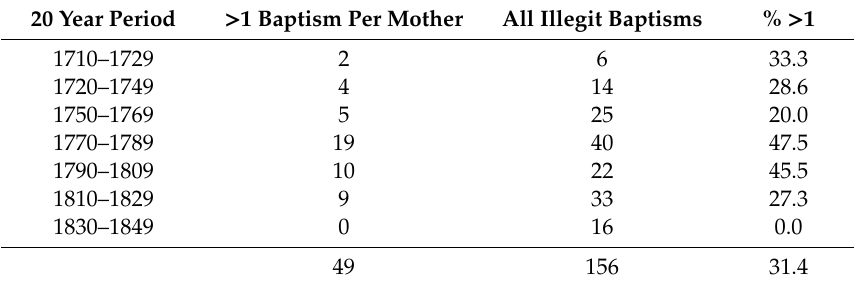
Figure 2. Total Number of Named Poor Relief Recipients Compared to Estimated Family Size Associated with Named Recipients, Butleigh Somerset, 1762–1834. Table 1. Numbers and Proportion of Illegitimate Baptisms in Butleigh to Mothers of One and More than One Illegitimate Child.